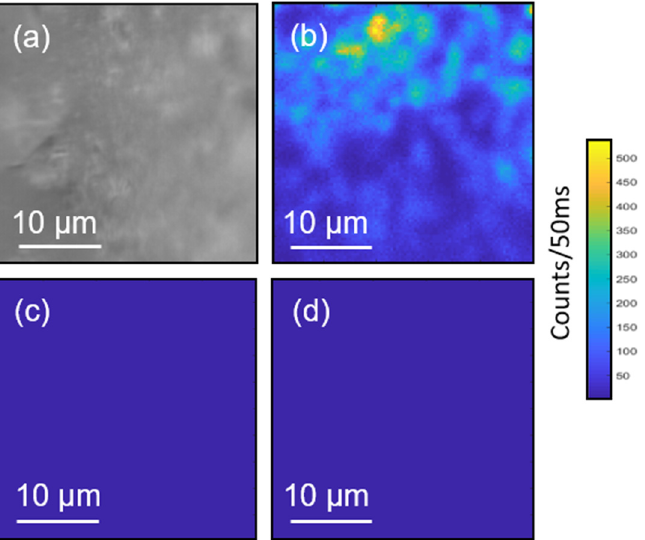
Figure 4. ( a ) Brightfield microscopy image of the drop-casted Cs 2 TiBr 6 NCs. ( b – d ) Scanning THG maps at band-pass filters FF01 356/30-25, 320/40-25, and 385/26-25, respectively. The image resolu- tion is 100 × 100 pixels, and the pixel dwell time is 50 ms.